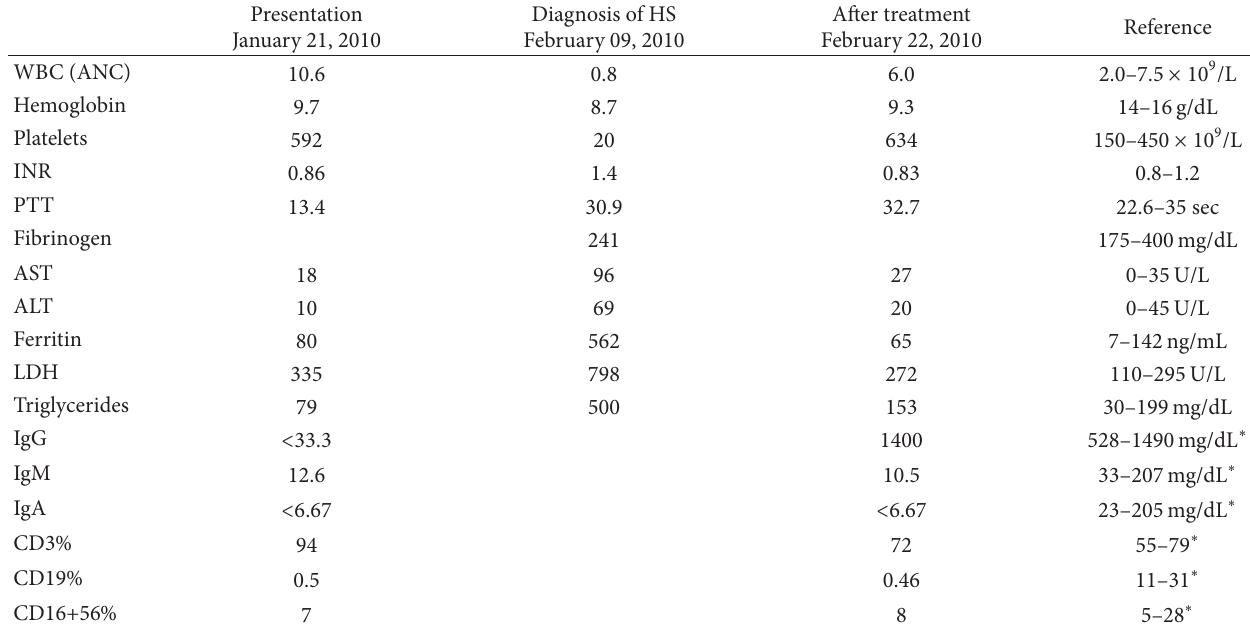
F 1: BTK mutation of the patient (c.1581_1584delTTTG). T 1: Laboratory characteristics of the